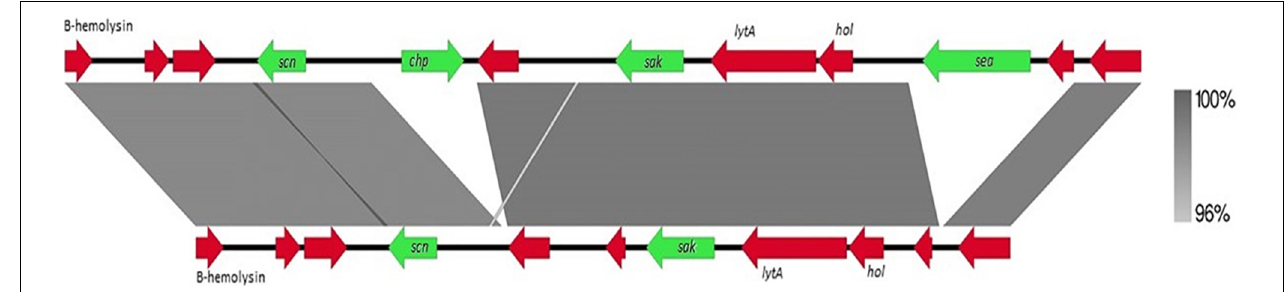
FIGURE 1 | Comparison of 3 (cid:48) conserved region of β -hemolytic bacteriophage ( (cid:56) 3) between reference strain MRSA-252 (above) and C6595 (below). The percentage of similarity is indicated (right). Arrows in green corresponding to the IEC genes, and in red other coding sequences.